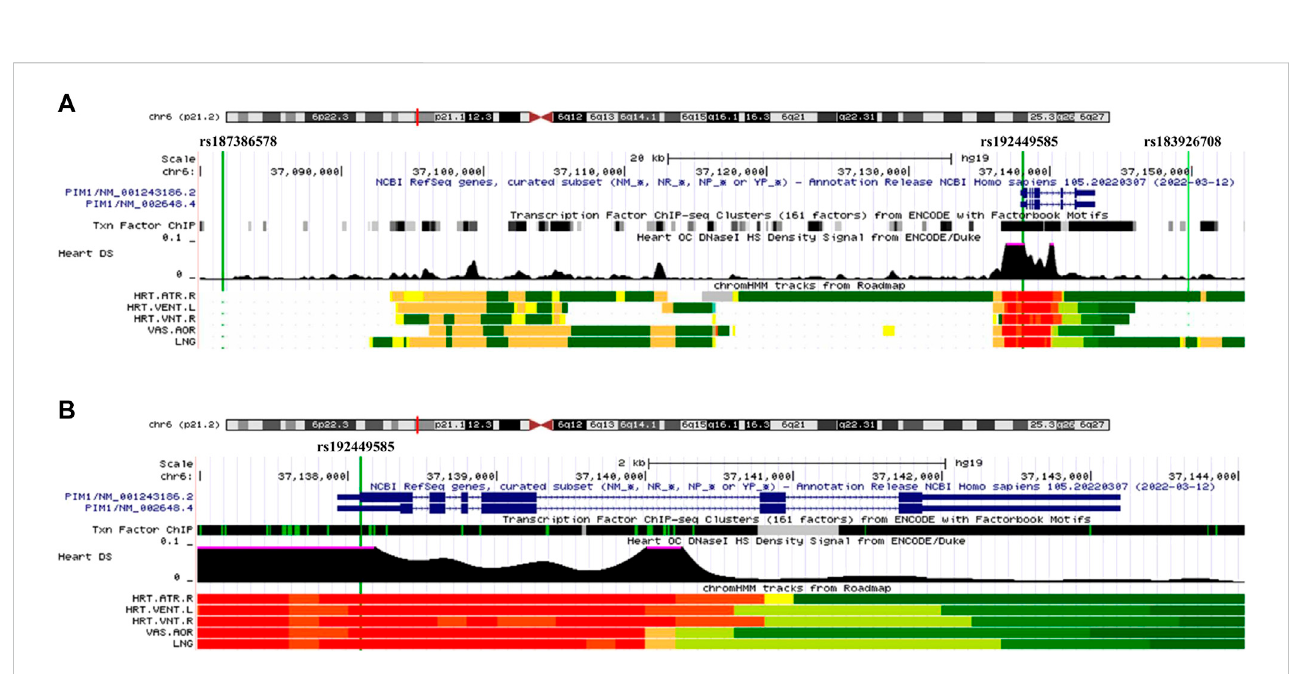
FIGURE 2 UCSCGenomeBrowserviewofgenomicregionfor PIM1 variants. (A) UCSCGenomeBrowserforallthreevariants.Greenverticallinedepictslocationof variant,labeledontop.Darkblueregionsindicatethe6exonsfor PIM1 plusuntranslatedregions(5 ′ and3 ′ UTRsarenarrowerdarkbluesections).Blackregion of “ Txn Factor ChIP ” indicates density of transcription factor ChIP-seq clusters from ENCODE. Black graphic for “ Heart DS ” indicates the Dnase I hypersensitivity density signal from ENCODE/Duke. Bottom fi ve tracks indicate the predicted chromatin state from Roadmap. Red indicates a transcriptionstartsiteregionfor fi vetissues, HRT.ATR.R(RightAtrium), HTR.VENT.L(LeftVentricle),HRT.VNT.R(RightVentricle),VAS.AOR(Aorta),LNG(Lung). (B) UCSC Genome Browser focused on exonic variant rs192449585 and PIM1